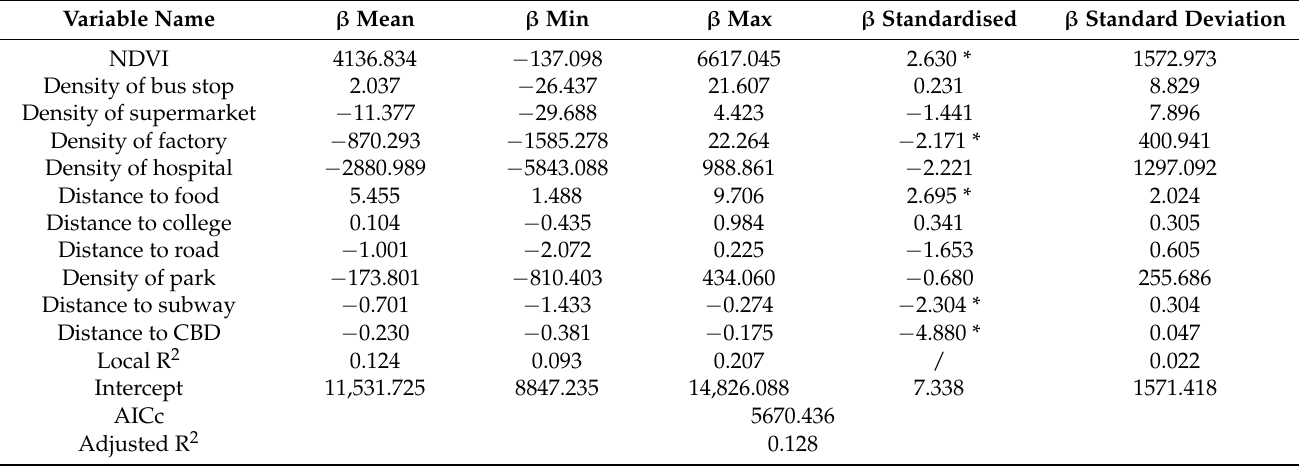
Table 5. Descriptive statistics of geographically weighted regression (GWR) estimation